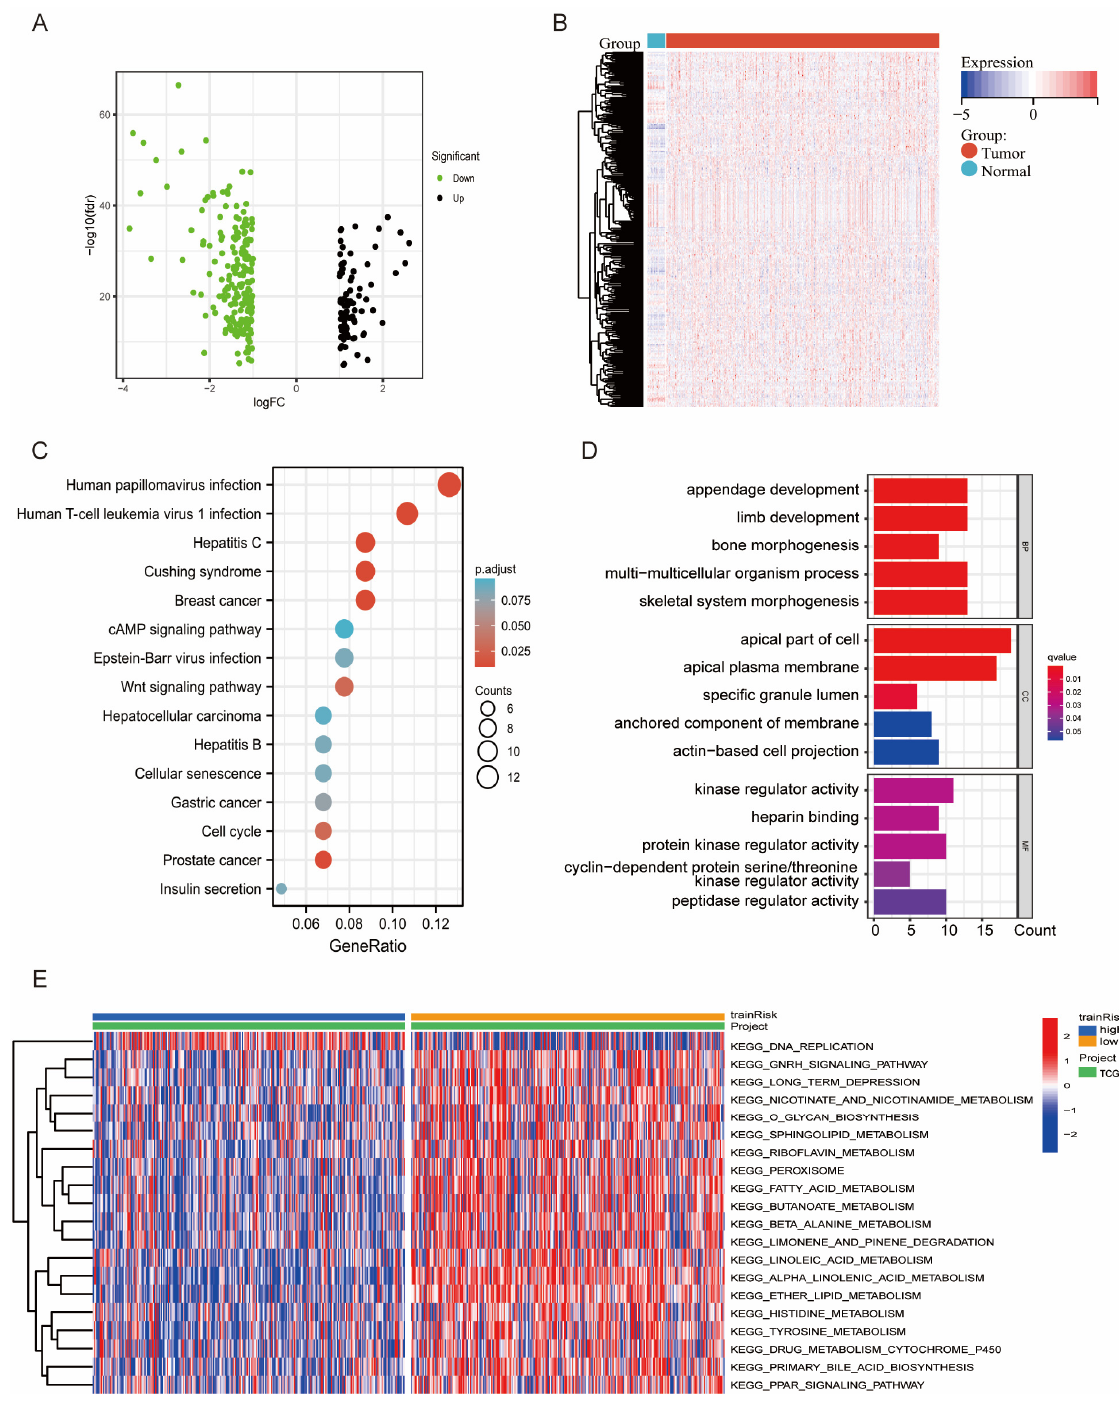
Figure 4. DEGs and functional enrichment of the signature. ( A , B ) The volcano plot and heatmap show the details of different genes between the high- and low-risk groups. ( C , D ) KEGG and GO functional enrichment analysis in terms of differentially expressed genes. ( E ) Gene set variation analysis between high- and low-risk patients based on TCGA-UCEC.